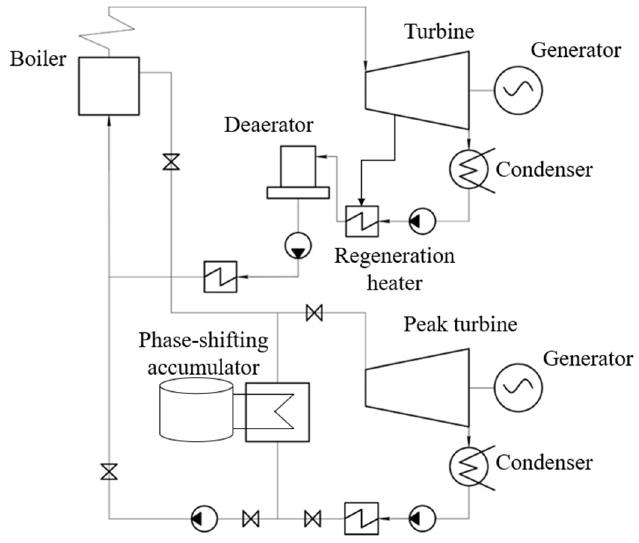
Figure 14. Heat flow chart of a TPP with phase transformation accumulator.